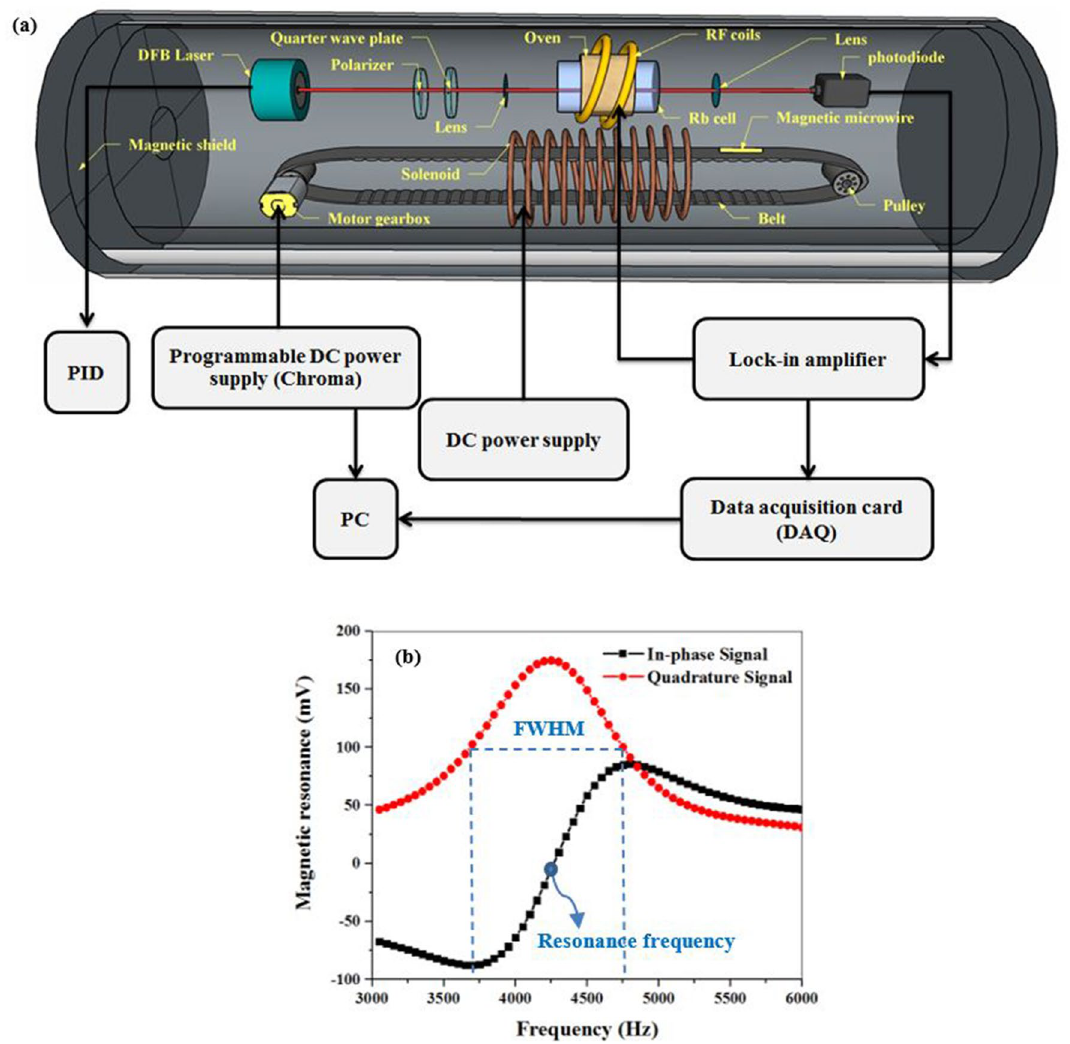
Figure 1. ( a ) Experimental setup for detecting the magnetic microwire, and ( b ) magnetometric signal as the output of the phase-sensitive detection which were proportional to the magnetic field and local magnetic field gradient of the moving magnetic target, respectively 29 . Experimental setup for detection of magnetic droplets. At the next step, to elucidate the role of instantaneous velocity measurements in stenosis detection, we have fabricated two artificial stenosis in an arte- rial phantom with different length of 7 mm and 14 mm. The phantom was a silicone tube with a 3 mm inner diameter. Small droplets of magnetic nanoparticle (Resovist (Bayer Schering Pharma) with concentration of 0.5 mmol Fe/ml) with equivalent diameter (1 mm) were generated in the tube using a programmable syringe- pump (IMSP96-1) and T-shaped inlet junction (As shown in Fig. 2). Magnetic nanoparticle droplets separated by the continuous air injection when we applied 20 mm/h flow rate for magnetic fluid phase and 600 mm/h flow rate for air phase. So, Liquid droplets generated within a gaseous flow (liquid-in-gas systems) 40 . The velocity of magnetic droplets is constant and slow. Therefore, the shape of the magnetic droplets doesn’t change and they don’t rotate during their movement. Magnetic droplets were magnetized with a long solenoid (with a 1 cm diameter and 36 cm length). In the weak magnetic field of the order of a few mT, the relation between the magnetism of the nanoparticles immersed in